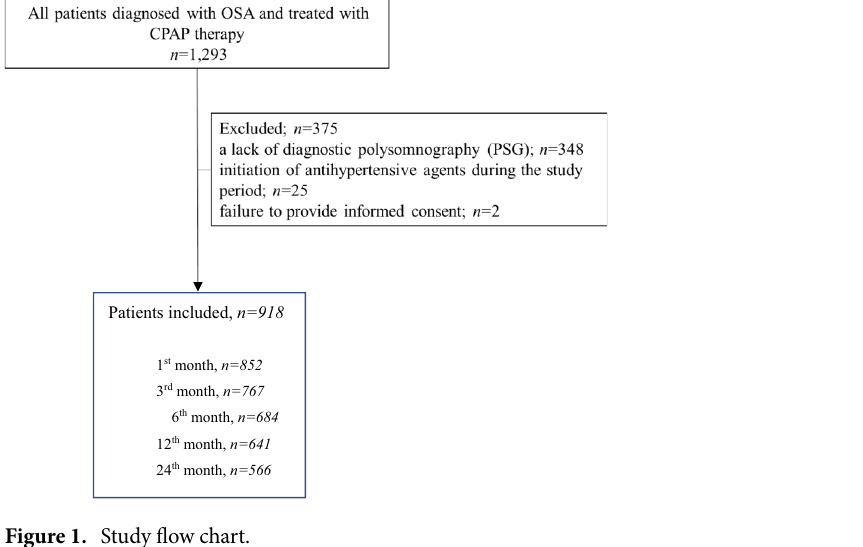
Figure 1. Study flow